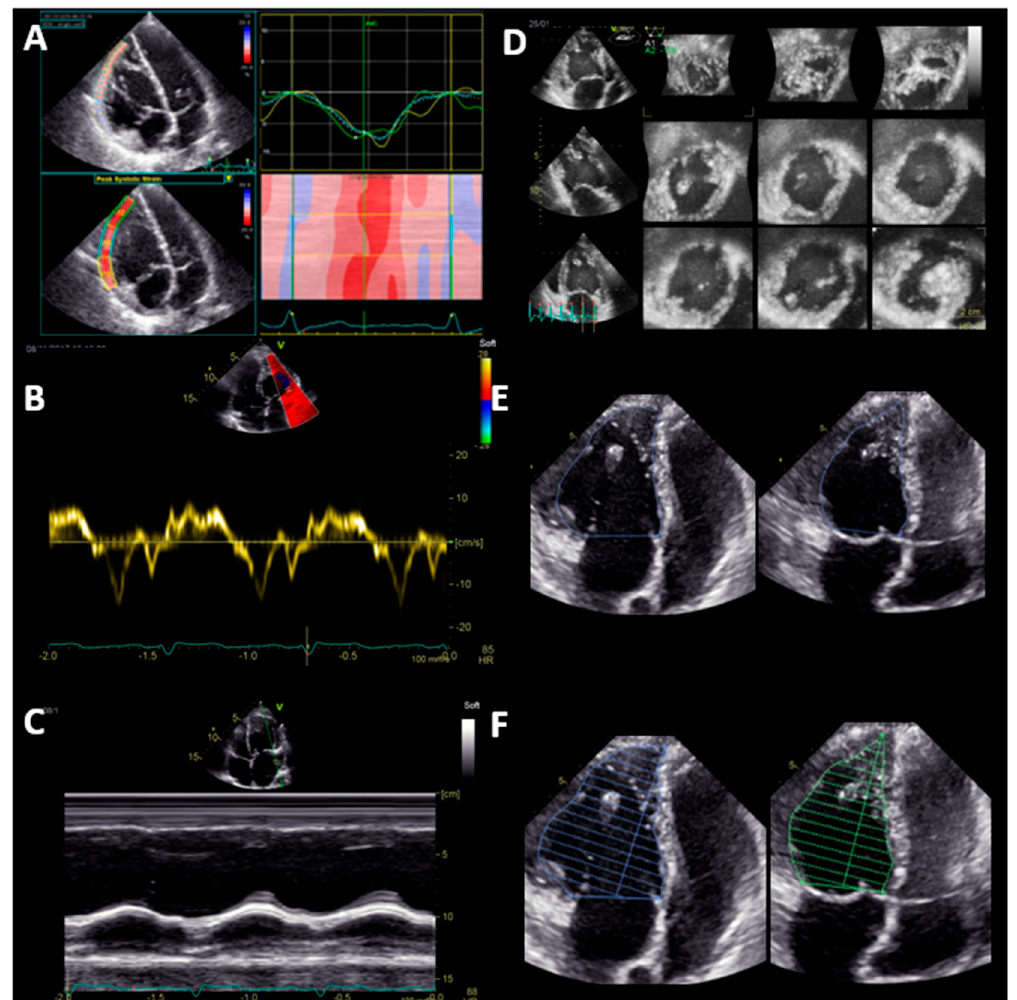
Figure 1. Systematic echocardiographic evaluation of systemic right ventricular function: Longitudinal function (Panel A-C) and volumetric function (Panel D-F). ( A ) Global longitudinal strain of the free lateral wall; ( B ) tissue Doppler velocity of the basal lateral wall S’; ( C ) tricuspid annular plane systolic excursion (TAPSE); ( D ) volumetric function assessed by 3D echocardiography; ( E ) fractional area change (FAC); ( F ) monoplane Simpson ejection